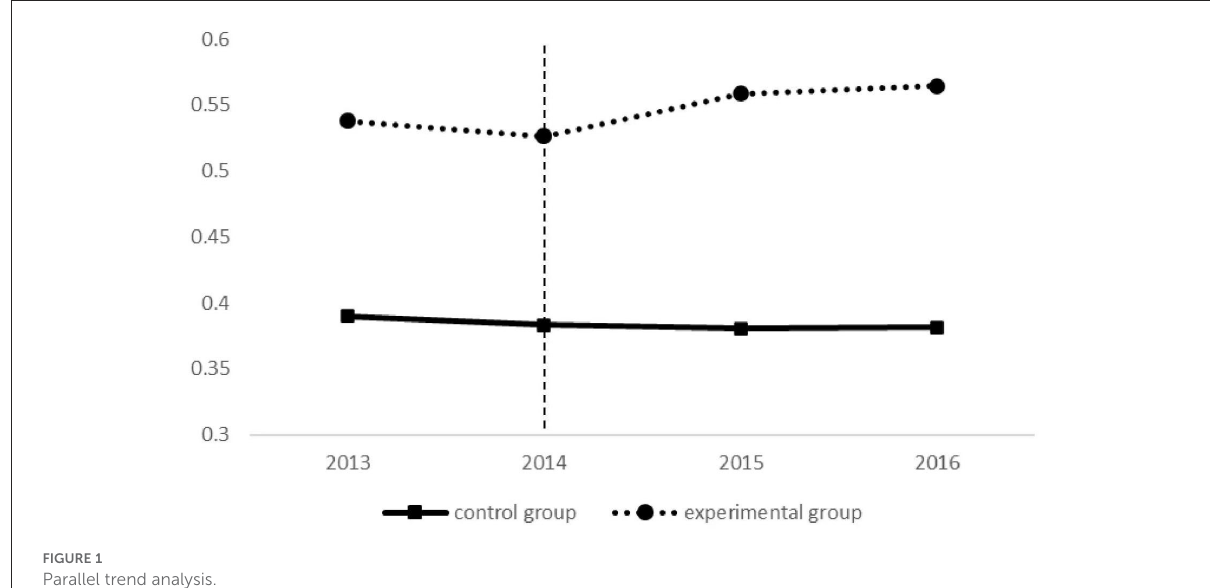
FIGURE1 Parallel trend analysis.